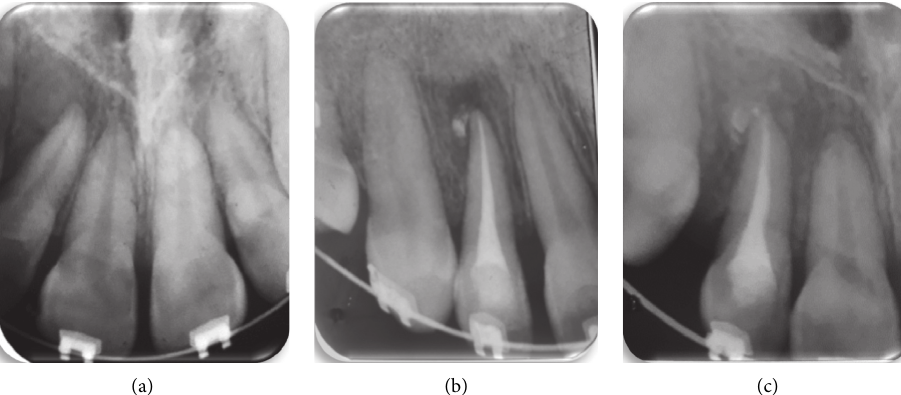
Figure 3: A case of a healing lesion: (a) preoperative radiograph; (b) postoperative radiograph showing the extrusion of Bioroot RCS; and (c) a 6-month follow-up